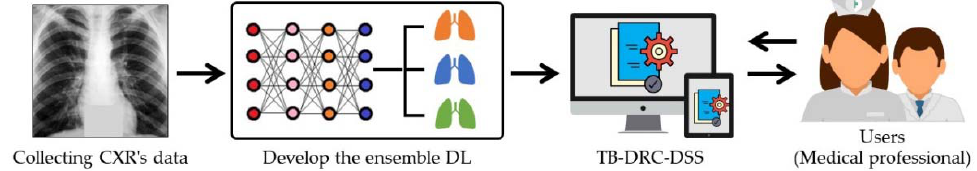
Figure 4. The development of the TB diagnosis supporting system (TB ‐ DRC ‐ DSS).